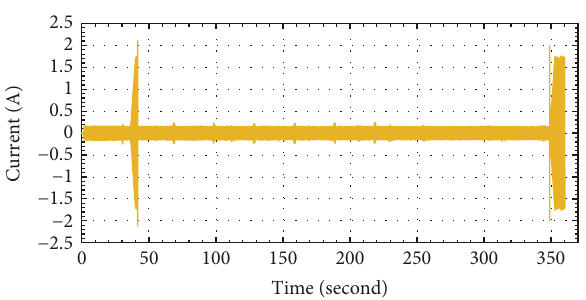
Figure 1: Overvoltage ramp test at a constant frequency. Light blue: control signal, green: simulated grid voltage (V), yellow: inverter output current (A).